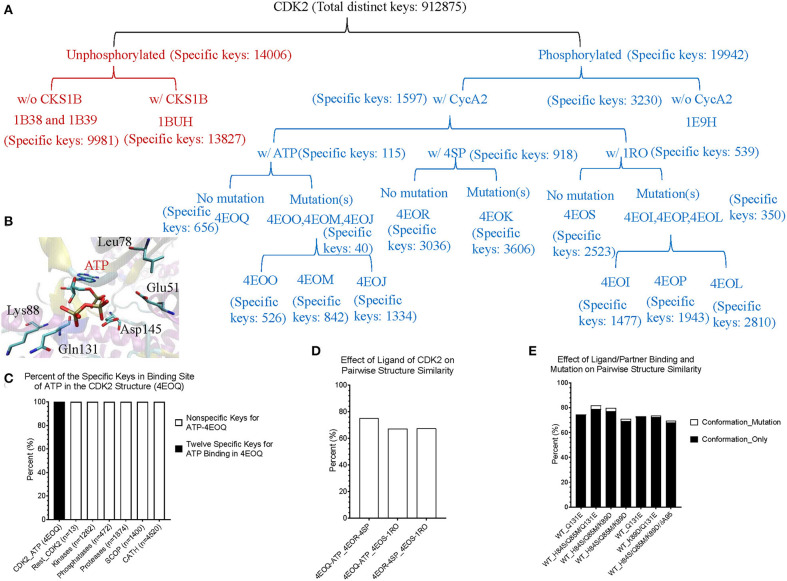
The results from the crystal structures of CDK2 reinforce that our structure-based protein comparison method can detect conformational changes of CDK2 with the same/similar amino acid sequences due to post-translational modifications or upon binding of a ligand and a partner. (A) It shows a hierarchical organization of CDK2 structures based on post-translational modifications, binding of a ligand or a partner, and with or without mutation(s). The total number of the distinct keys and numbers of specific keys for each (sub)group are identified and shown; (B) It shows ATP binding site of CDK2 (PDB ID: 4EOQ). Some of the amino acids associated with 12 specific keys for 4EOQ are shown; (C) The 12 keys specific to 4EOQ are shown. The identities of these 12 keys from 4EOQ can be found in Supplementary File 9. The PDB IDs, and chain and class information for kinases and phosphatases can be found in Supplementary File 10; (D) It shows pairwise percent similarity of CDK2 structures with identical amino acid sequence and without a mutation, but with different ligands: ATP, 4SP and 1RO; (E) It shows pairwise percent similarity of CDK2 structures with mutation(s) compared with their corresponding structures without mutations. WT, wild type means no mutation. Conformation_Only means structural comparison with a different label for each mutation and Conformation_Mutation means structural comparison with changing mutated label(s) back to their original one(s) for distinguishing the sources of dissimilarity.